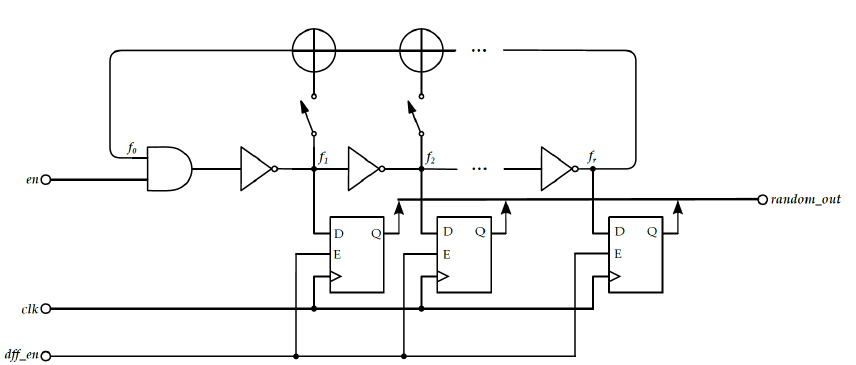
Figure 11. Fibonacci Ring Oscillator with state sampling. The output bus is XORed together to form a 1-bit output in the higher level.